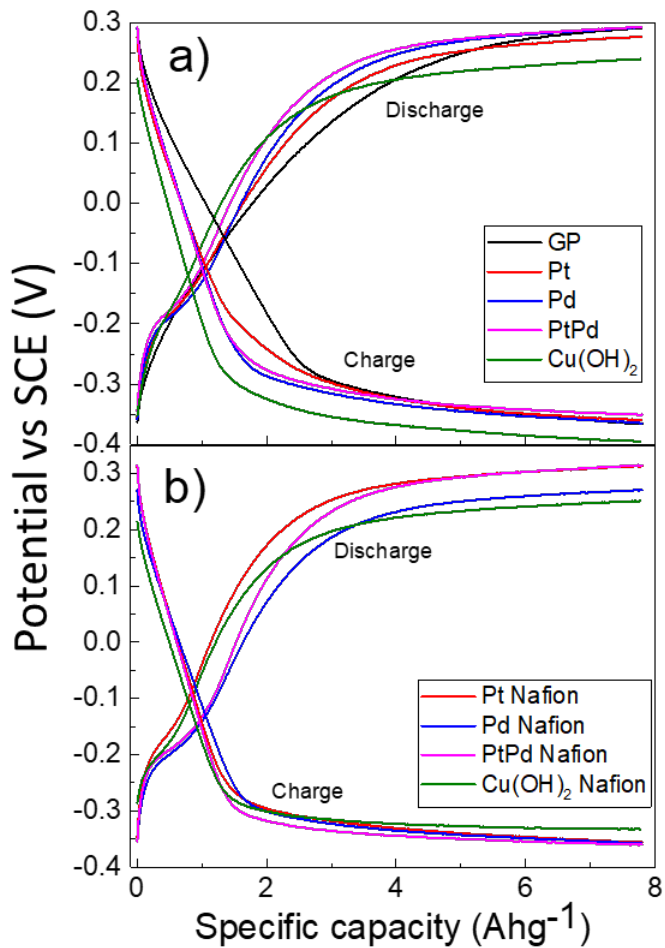
Figure 4. Galvanostatic charge and discharge curves of GP alone (black line), Pt (red line), Pd (blue line), Pt 80 Pd 20 (magenta line), and Cu(OH 2 (olive line): ( a ) drop casting by water suspension; ( b ) drop casting by suspension in water 0.25% wt. Nafion. Conditions: KOH 1 M; current ± 100 µ A. The specific capacity was calculated with respect to the mass of 1 cm 2 of